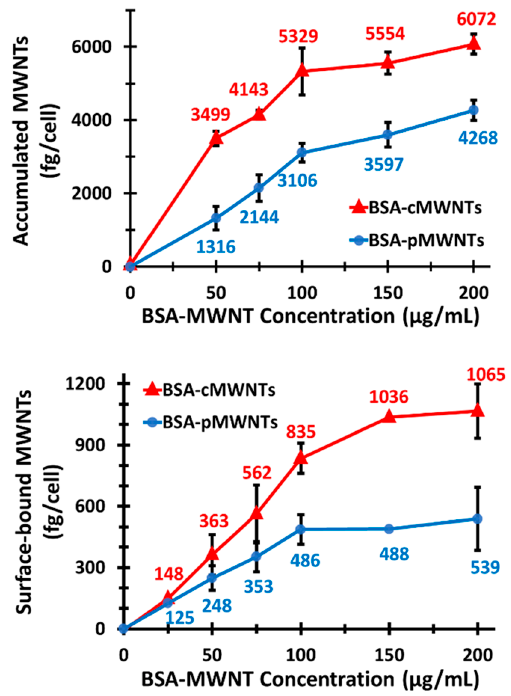
Figure 2. Accumulation at 37 ◦ C and surface binding at 4 ◦ C of BSA-MWNTs by RAW 264.7 cells as a function of the applied BSA-MWNT concentration. MWNTs suspended in a 0.10 mg/mL BSA working solution were mixed with an equal volume of 2X-concentrated medium to produce MWNT concentrations shown in the x-axes of the graphs. Exposure to a 0.10 mg/mL BSA working solution alone (in the absence of MWNTs) was the control. ( Top ) RAW 264.7 cells in 6-well plates were incubated at 37 ◦ C for 24 h in complete medium with serum that contained either BSA alone, BSA-pMWNTs (blue line), or BSA-cMWNTs (red line). After incubation, MWNTs were extracted from cells and quantified by the SDS-PAGE method. ( Bottom ) Cells in 6-well plates were pre-incubated with serum-free medium (in the absence of BSA-MWNTs) for 2 h at 37 ◦ C to deplete the serum in the cells. The cells were then pre-chilled to 4 ◦ C and incubated at 4 ◦ C for 1 h in serum- and sodium bicarbonate-free medium that contained either a 0.10 mg/mL BSA working solution without MWNTs, with BSA-pMWNTs (blue line), or with BSA-cMWNTs (red line). After incubation, surface-bound MWNTs were extracted and quantified by the SDS–PAGE method. For both data sets the numbers above the data points are the mean femtograms of MWNTs/cell; each data point is the mean of ≥ 3 independent experiments ±